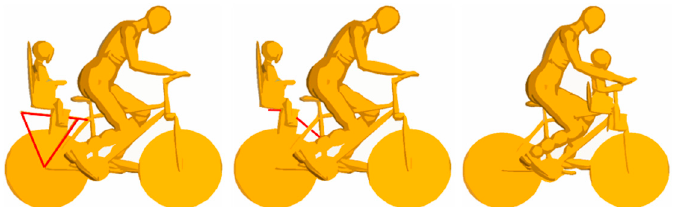
Figure 5. Mounting configurations of bicycle-mounted seat—rear-rack ( left ), rear-frame ( middle ), front ( right ).